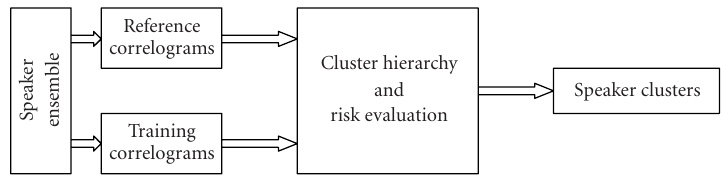
Figure 1: Clustering speaker using correlograms.